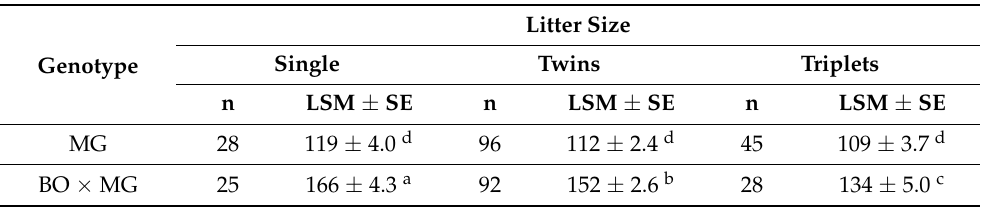
Table 8. Least Square Means (LSM ± SE) of the average daily gain (ADG, g/d) from birth to 9 kg live weight of kids according to the genotype (crossbred and purebred) × litter size interaction. Crossbred kids were from Boer bucks × Murciano-Granadina goats (BO × MG). Purebred kids were Murciano-Granadina breed